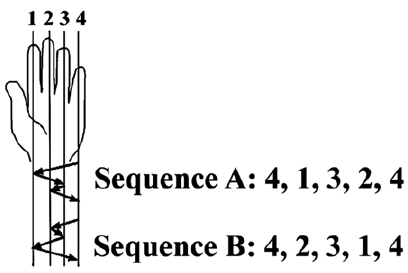
Figure 1. The finger-to-thumb opposition task. The two sequences were matched for number of movements per digit and mirror-reversed in relation to each other (in terms of